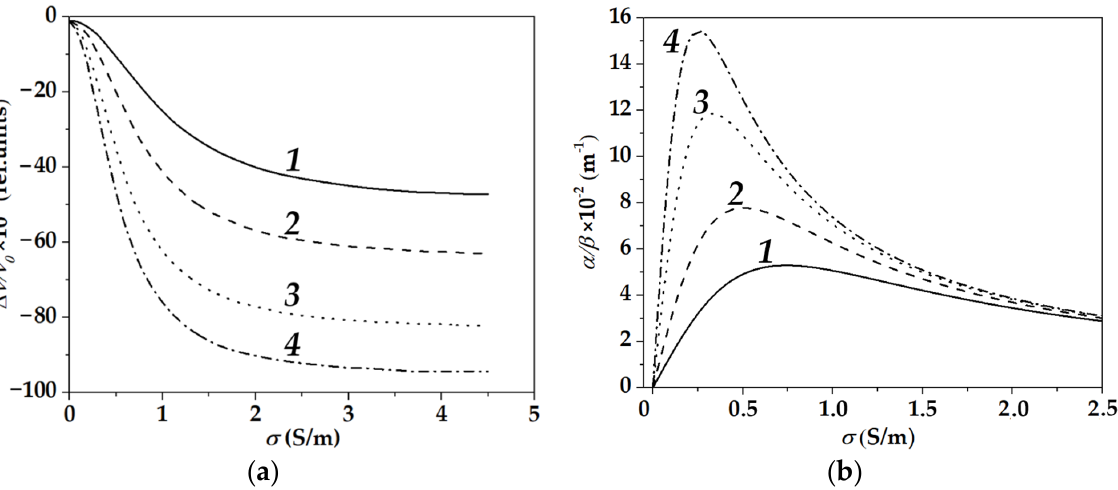
Figure 3. Changes in phase velocity Δv/v o ( a ) and acoustoelectric attenuation α/β ( b ) versus liquid conductivity σ and dielectric permittivity ε lq calculated with formulas (2) and (3). Liquids: ε lq / ε 0 = 79.3 (1), 52.5 (2), 32.9 (3), and 24.2 (4). Plate: 128°YX -LiNbO 3 , h = 500 μm, ε pl = 34ε 0 . Wave: λ = 300 μm, ε lq / ε 0 = 79.3 (1), 52.5 (2), 32.9 (3), and 24.2 (4). Plate: 128 ◦ YX -LiNbO 3 , h = 500 µ m, ε pl = 34 ε 0 . Wave: v = 14.093 m/s, k 2 = 116 × 10 −4 , ω =10 9 s −1 , displacements on the plate faces are { u 1 , u 2 , u 3 ,} = {1, 0.36, λ = 300 µ m, v = 14.093 m/s, k 2 = 116 × 10 − 4 , ω =10 9 s − 1 , displacements on the plate faces are 0.34}. β is the wave number. { u 1 , u 2 , u 3 ,} = {1, 0.36, 0.34}. β is the wave number.